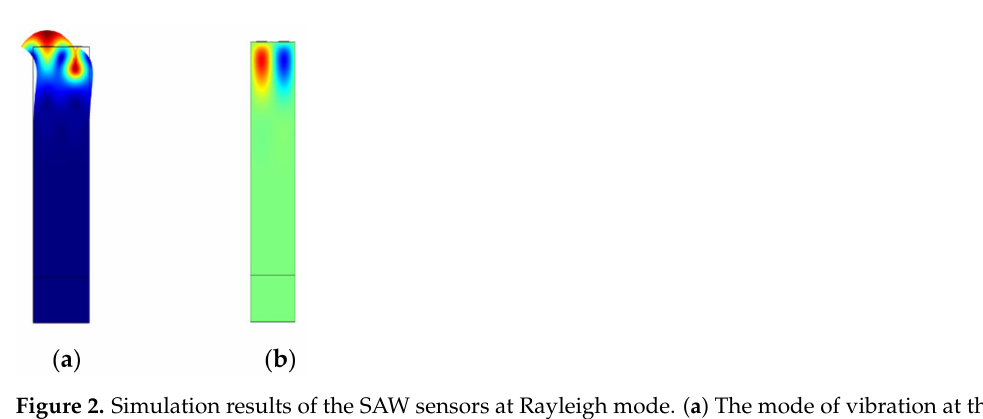
Figure 2. Simulation results of the SAW sensors at Rayleigh mode. ( a ) The mode of vibration at the resonant frequency, ( b ) the corresponding potential diagram.